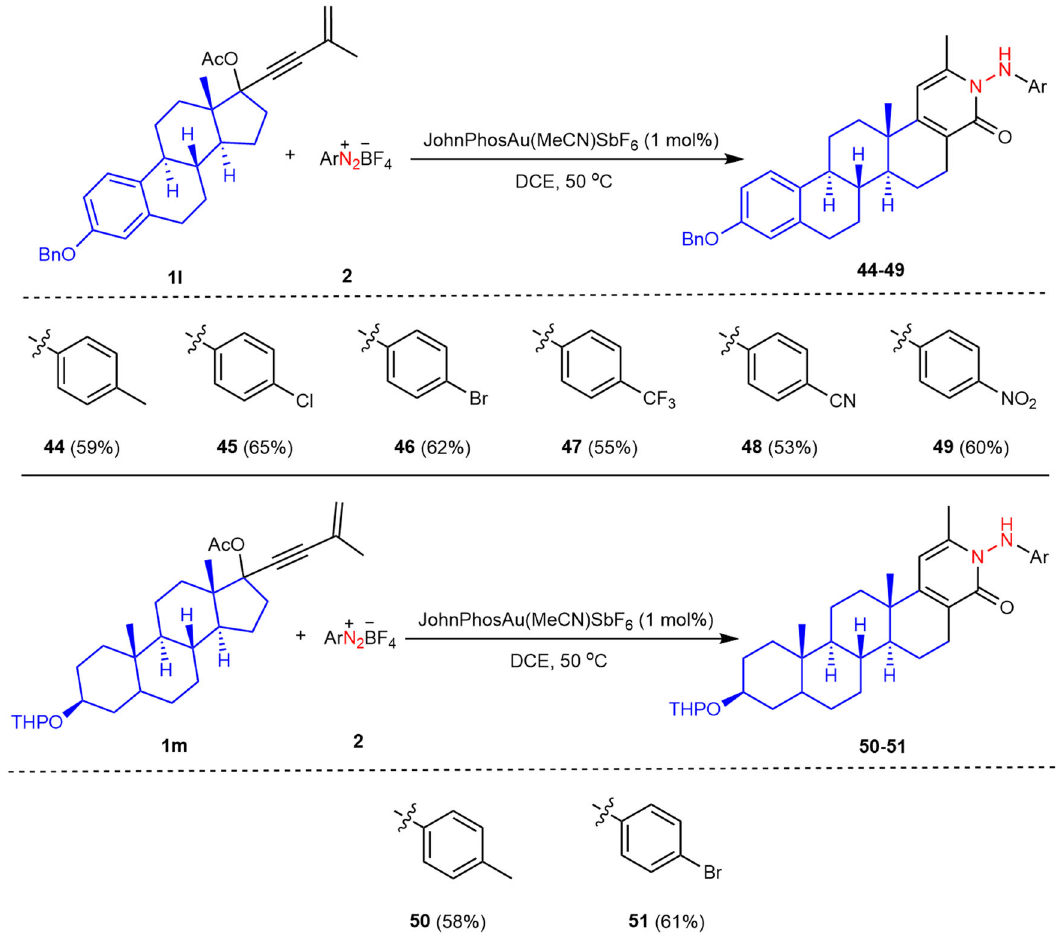
Fig.3|Schmidt-typereactionforthesynthesisofazasteroids. Reactionconditions: 1l or 1m (0.2mmol), 2 (0.4mmol),JohnPhosAu(MeCN)SbF 6 (1mol%),DCE(2.0ml), 50°C, 6h; the yield refers to isolated yield based on 1